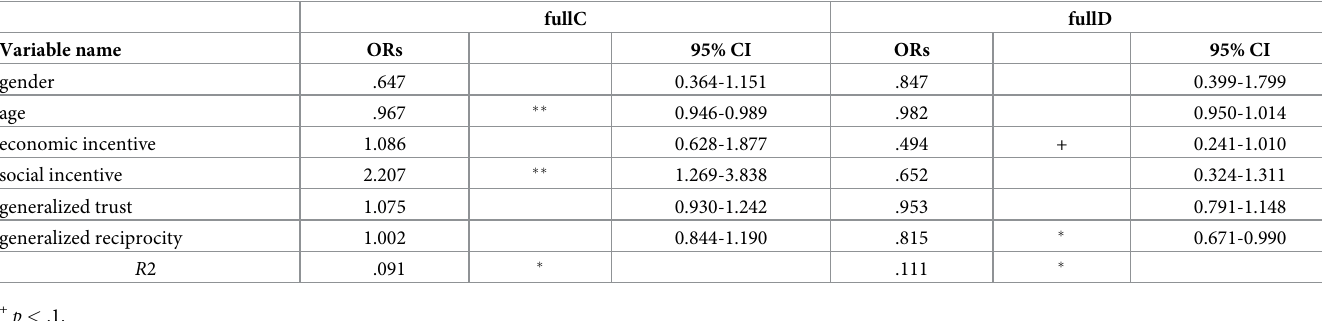
Table 2. Effect of incentives on full cooperation and defection including psychological